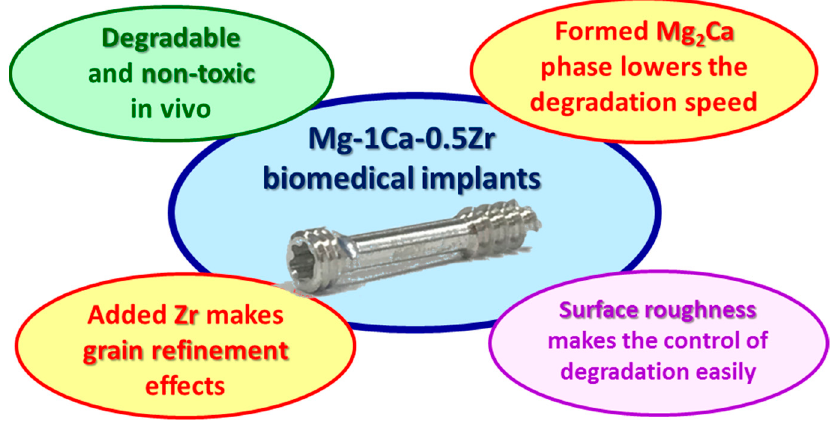
Figure 18. Summary of Mg-1Ca-0.5Zr biomedical implants.